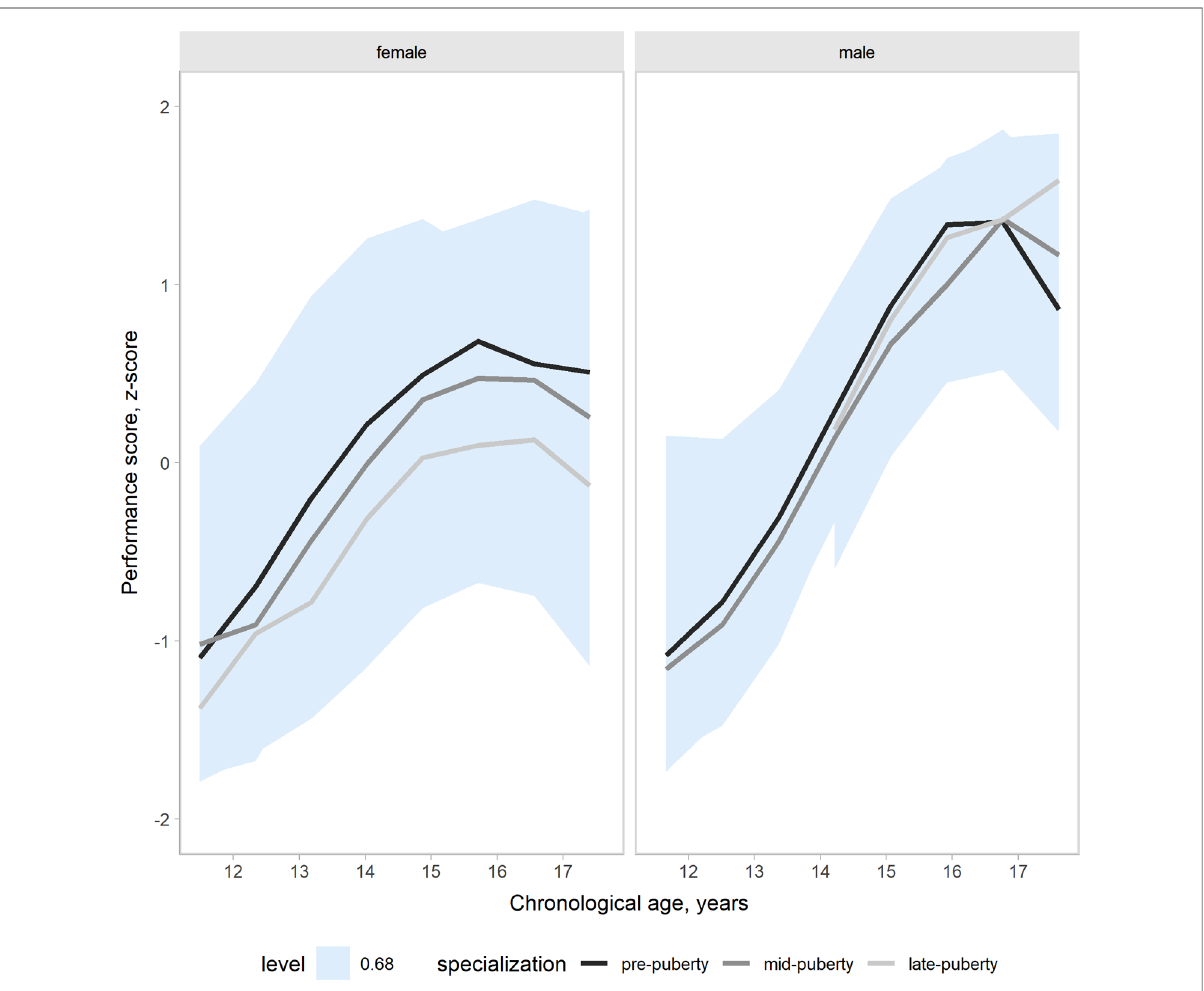
FIGURE 8 Developmental changes in overall basketball-speci fi c physical fi tness performance index for young females and male basketball players by specialization onset. The shaded area represents the 68% credible interval, similar to a standard